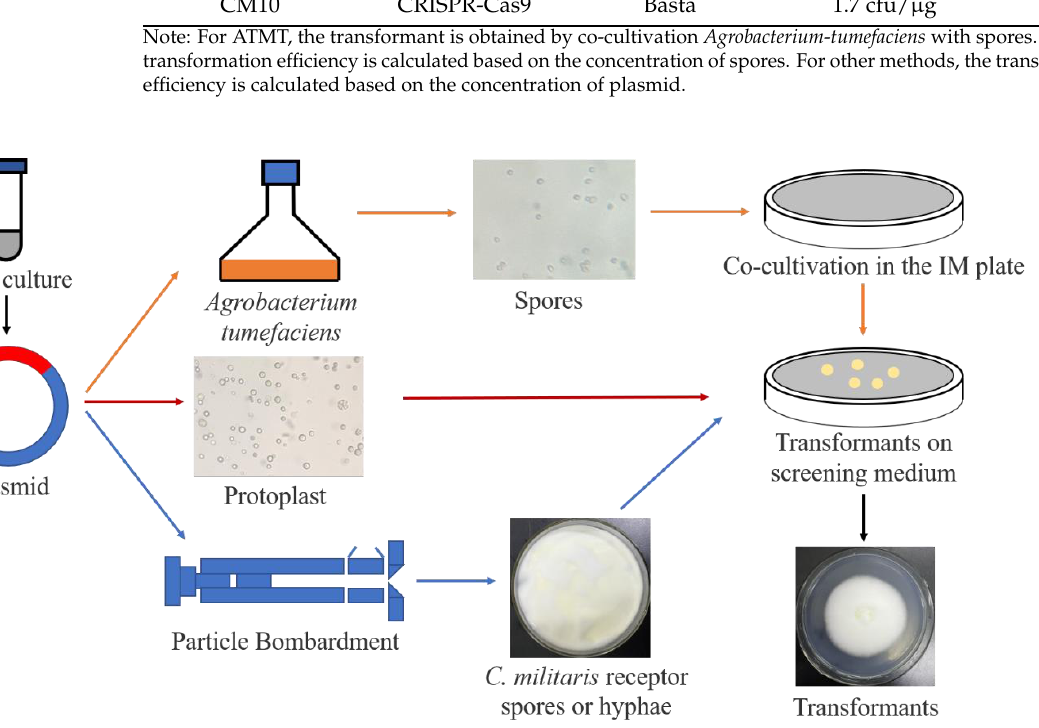
Figure 3. Genetic modification methods of C. militaris . Constructed plasmid with target gene was extracted from E. coli and transformed by ATMT, PMT and PB methods. For the ATMT method, the plasmid was transferred into Agrobacterium , followed by co-cultivation with C. militaris spores. For the PMT method, the plasmid (including split marker DNA) was transferred into protoplast mediated by PEG (polyethylene glycol). For the PE method, the plasmid was coated with gold powder, and the broken mycelium suspension of C. militaris plated in medium was used as the receptor material for transformation. Finally, the transformant was screened in the corresponding medium for all methods. The transformants were further confirmed by polymerase chain reaction (PCR) or the expression of a reporter gene.